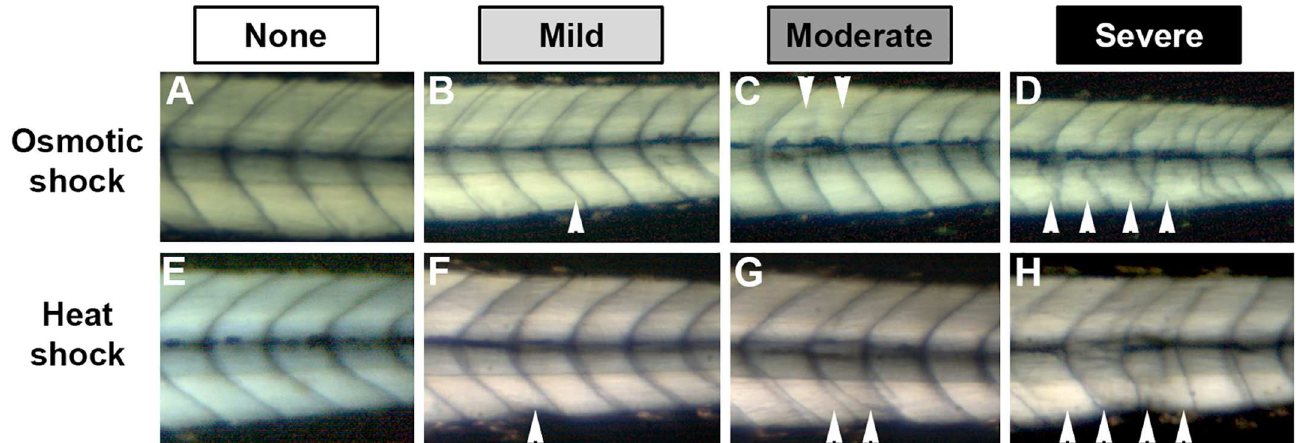
Fig 1. Osmotic and heat shock lead to variable segment border defects. Embryos were shocked at the 9 somite stage with a 840 mOsm solution (A-D) or 37˚C embryo medium (E-H) for 45 minutes and allowedto developuntil approximately 72 hpf. Arrowheadspoint to visible somite border defects. (A,E) Embryos exhibitingno defects. (B) The ventral portion of a somite border is curved. (C) The dorsal half of a somite border failed to form. (D) Multiple irregularly-formed somite boundaries.(F) A somite border is curved and the somite is narrow. (G) The ventral portion of two consecutive borders failed to reach the end of the somite. (H) Multipleirregularly-formed somite borders.